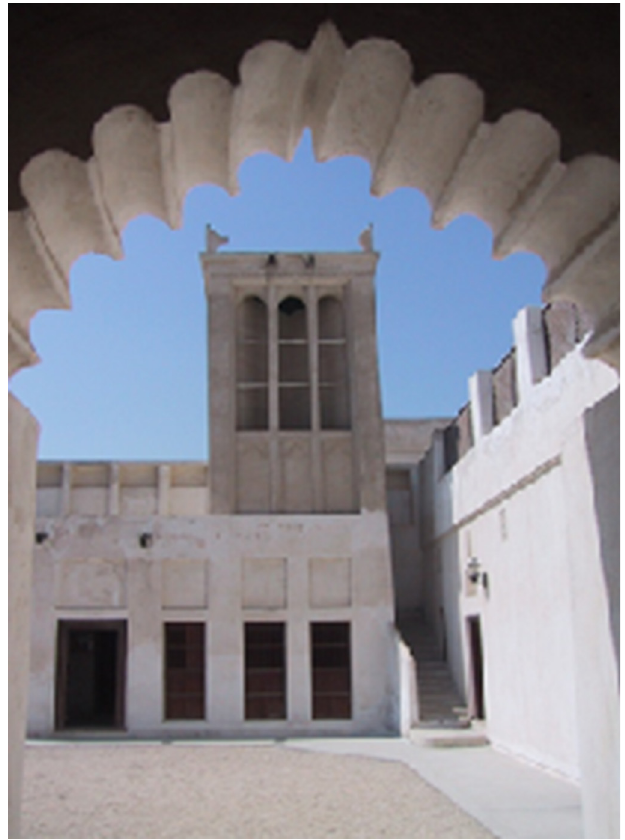
Fig. 1. A traditional house with a courtyard and a wind tower to relieve the harsh climate of the inner spaces of houses. Muharraq, Kingdom of Bahrain. Source: Photograph by the Author, 2016.